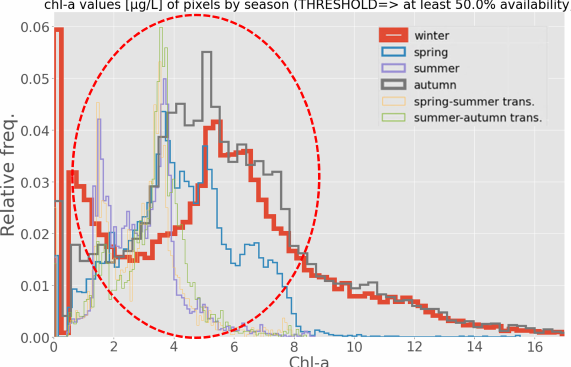
Figure 10. Histograms per season- Chlorophyll-a (Lake Lugano).